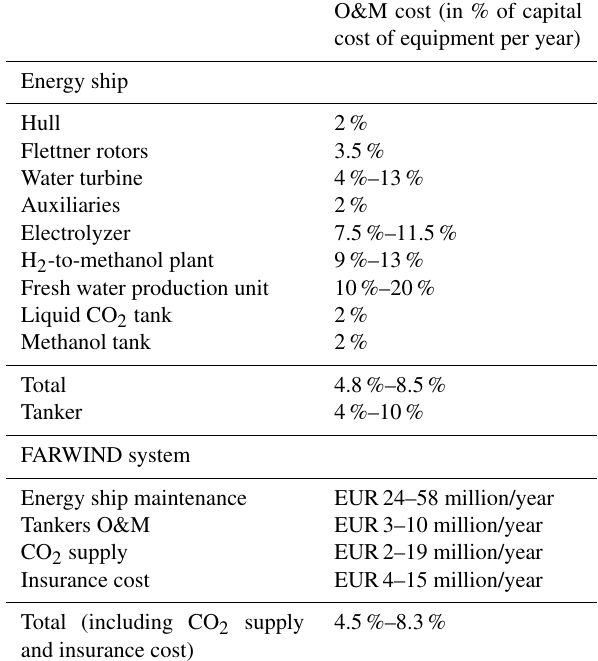
Table 3. Estimates of the operation and maintenance of a first-of-a- kind FARWIND energy